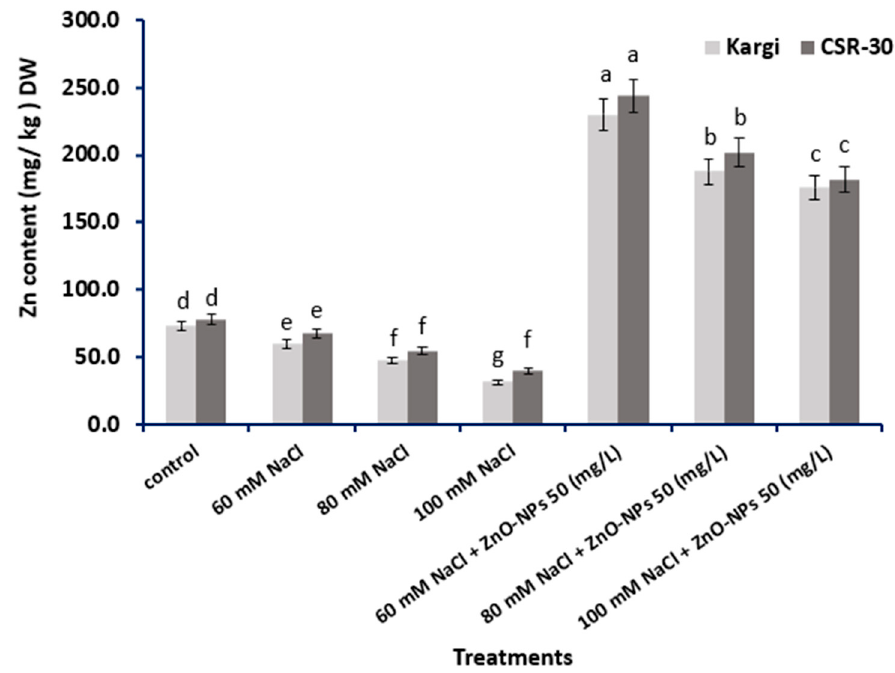
Figure 5. Impact of ZnO-NPs on Zn content in leaves of Kargi and CSR 30 Oryza sativa genotype in control and under saline conditions. Small alphabets (a–g) indicate a statistically significant difference between treatments concerning control. Values are means of three replicates. Error bars indicate the least significant value (LSD) at p ≤ 0.01 among the treatments.